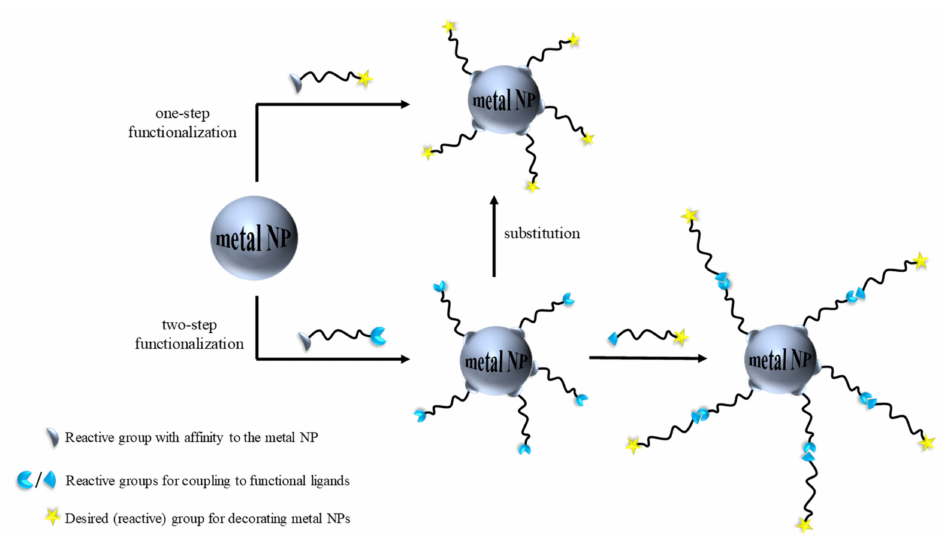
Figure 2. Two approaches are instrumental in producing decorated MNPs by utilizing appropriate functional ligands in either one-step or two-step